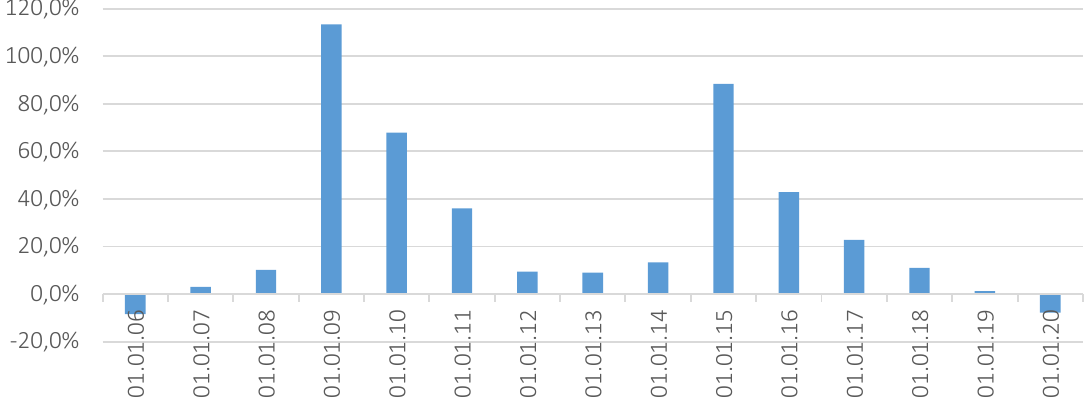
Figure 3. Annual growth rates of Ukraine’s State Debt for 2004–2020, %